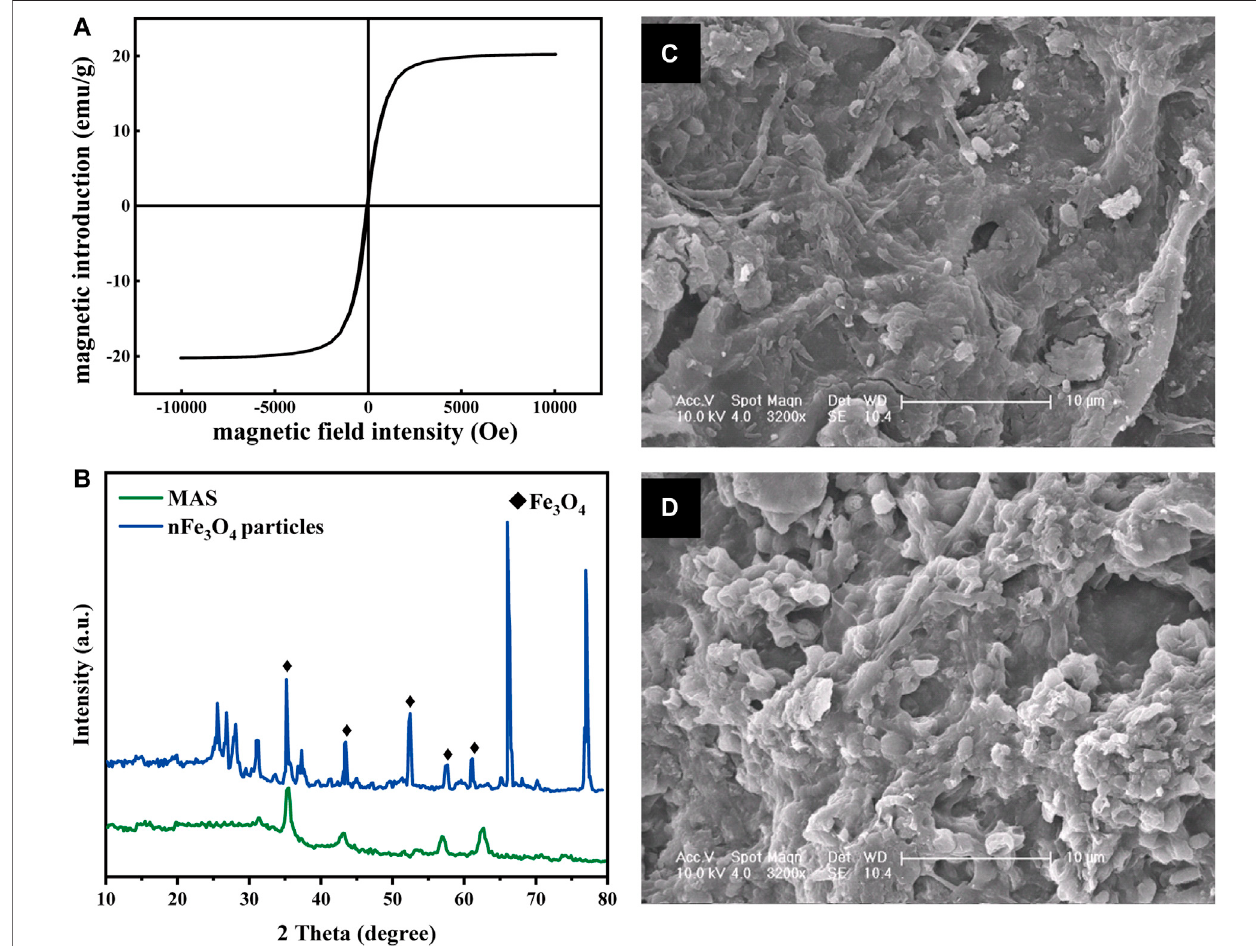
FIGURE2| CharacterizationofMAS. (A) Magnetic hysteresis loop ofMAS; (B) XRDpatternofnFe 3 O 4 particles (blue) and MAS (green) (C) and (D) SEM images of bio fi lms on MAS and AS, respectively (×3200 times).